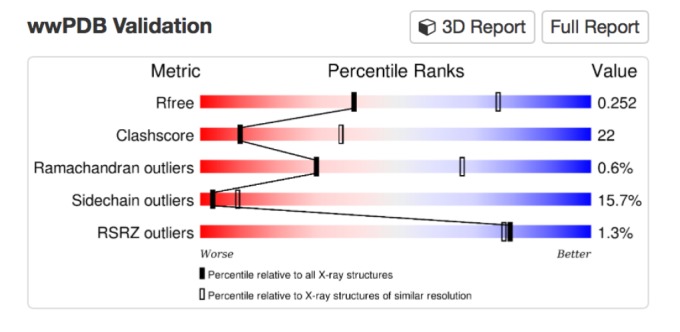
DOI:
http://dx.doi.org/10.7554/eLife.22567.028